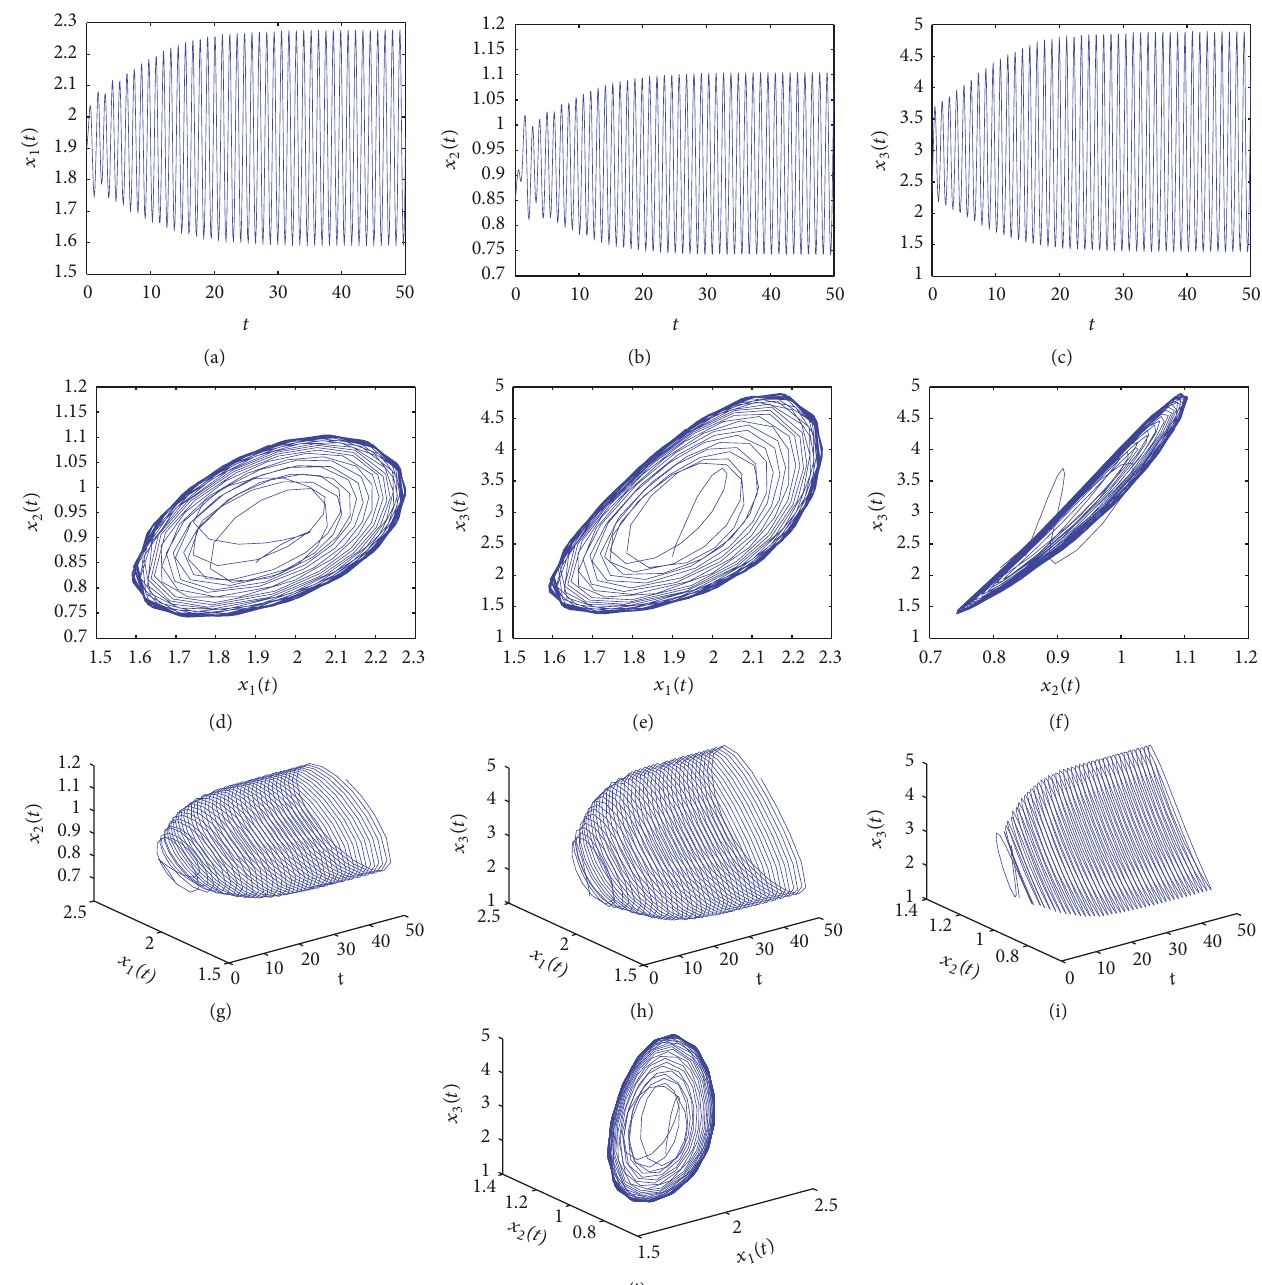
Figure 2: Dynamical behavior of system (81) with 𝜏 = 0.28 > 𝜏 0 ≈ 0.265 . Hopf bifurcation occurs from the positive equilibrium 𝐸 (1.9170, 0.9170, 2.9251) . The initial value (𝑥 0